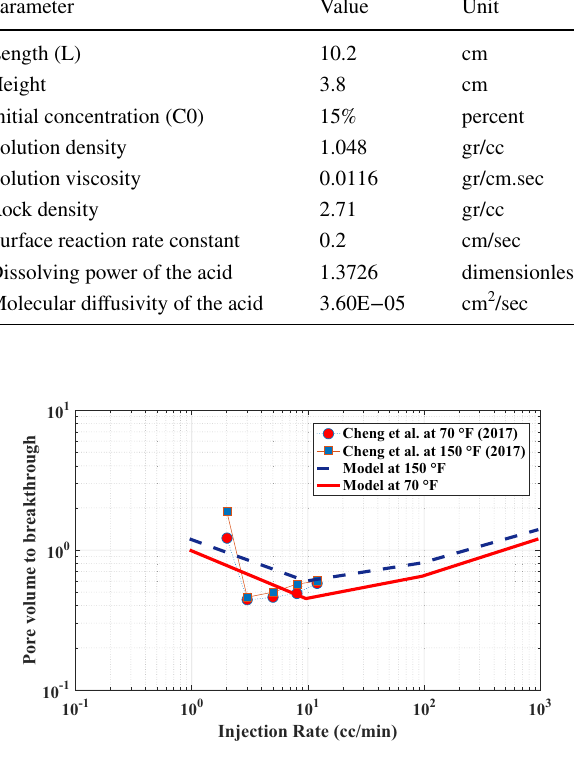
Fig. 6 Comparison of the results of the Cheng et al. experiments (2017) and the developed model at two different